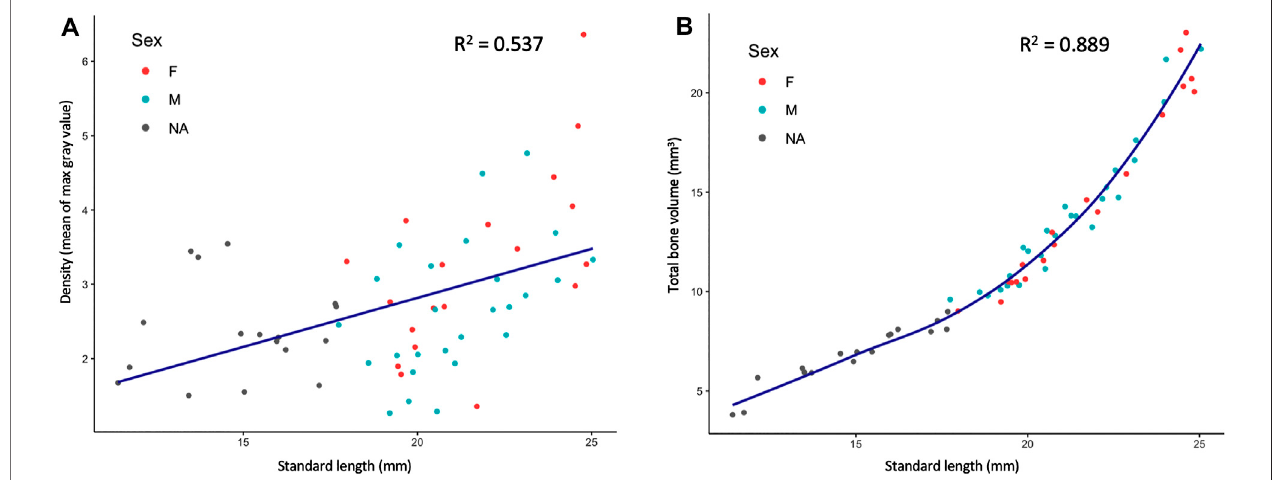
FIGURE 3 | Quanti fi ed skeletal density and volume relative to linear growth. (A) , Bone density relative to SL. (B) , Total bone volume relative to SL. Bone volume calculated from all cross sections of scan.